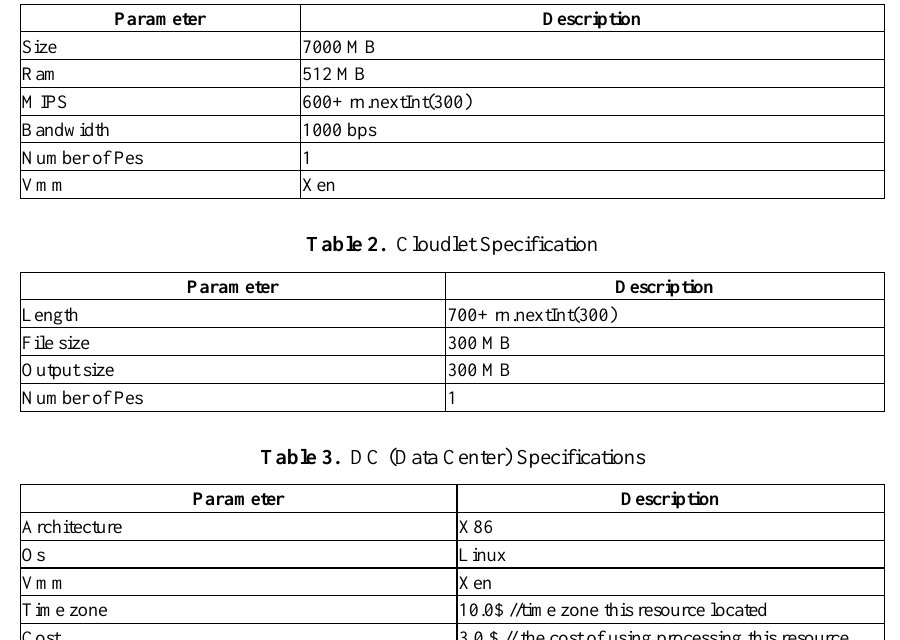
Table 1. VM Specification